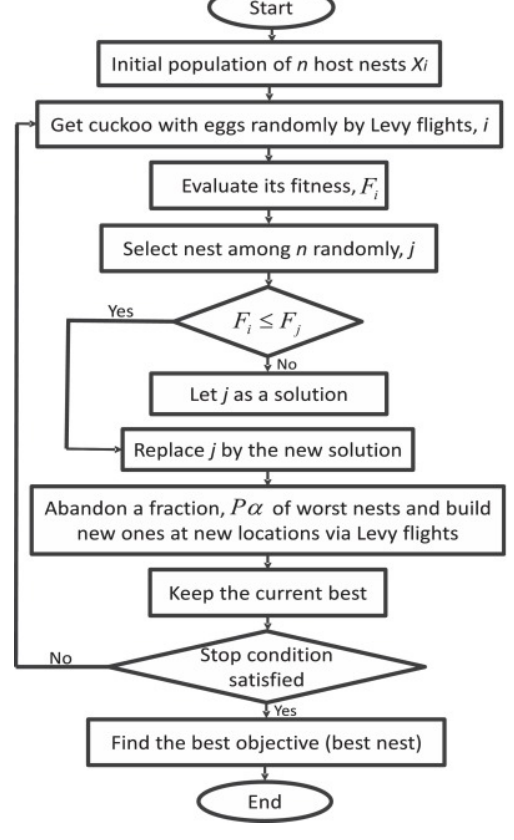
Figure 6. Steps of CS